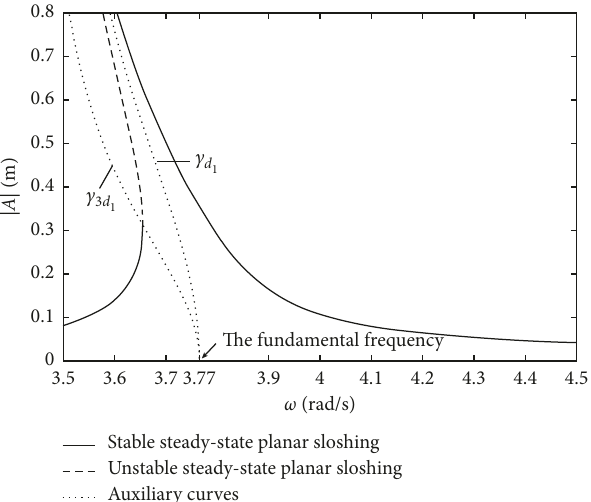
Figure 22: Steady-state planar wave amplitude response ( ω , | A | ) in the frequency domain for X